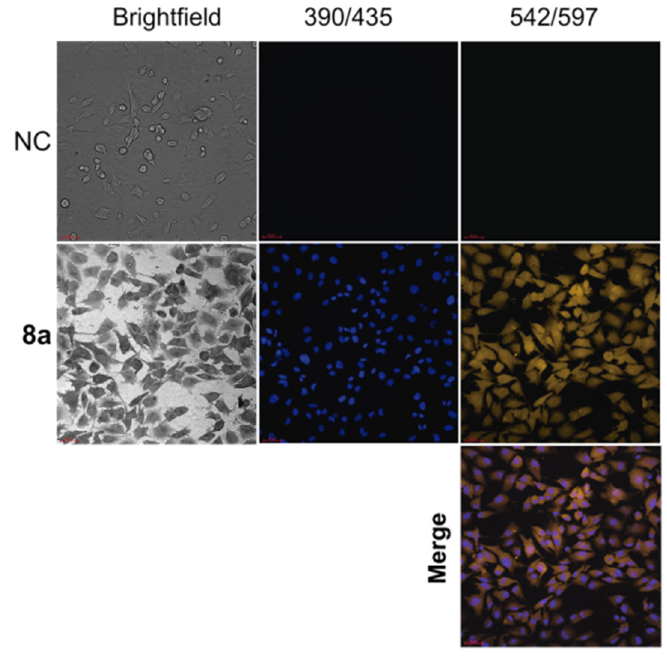
Figure 9. Fluorescent staining of live cells using the meso -substituted cyanine 8a (5 μ M). The images were obtained 30 min after incubation. NC = control. The first column shows the brightfield, the central column showsthe fluorescence of cells incubated with the nuclear dye Hoescht, and the third column shows cyanine 8a. The first line represents cells without dye (negative control), the second line represents cells exposed to cyanine 8a, and the third line represents the merge of Hoescht and cyanine 8a . Scale bar (red) = 60 μ m.